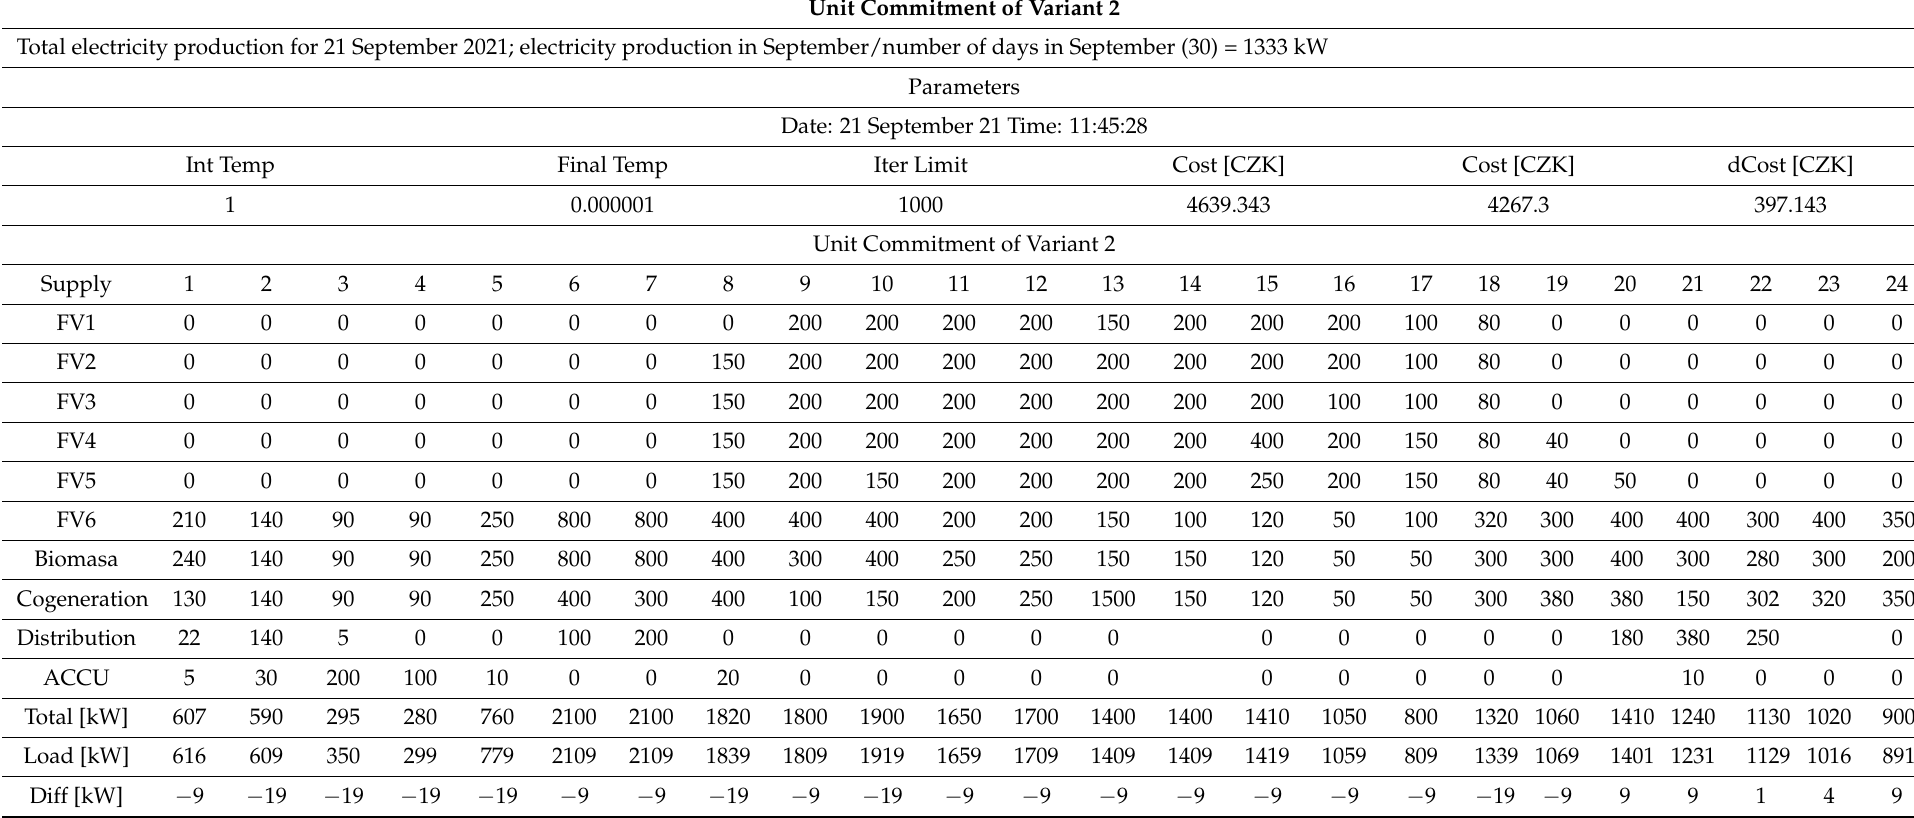
Table 7. Unit Commitment of the RES microgrid (Figure 14) for working day Thursday. Unit Commitment of Variant